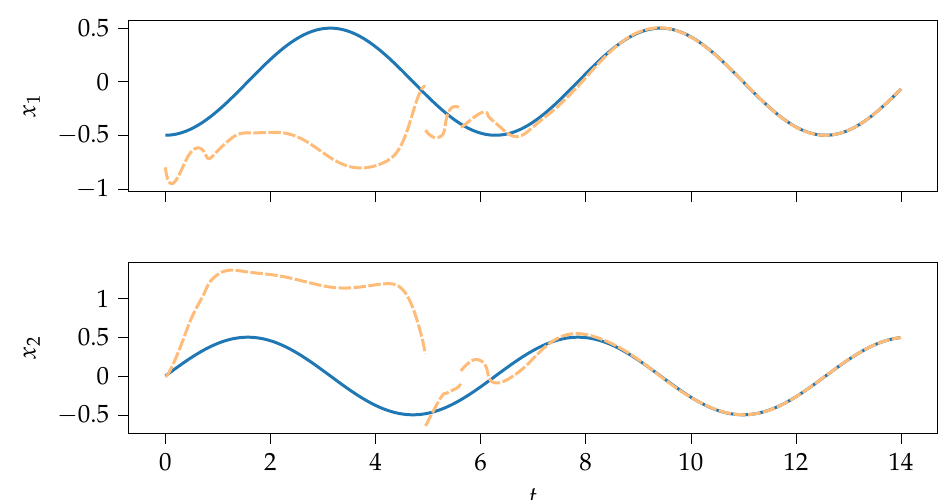
Figure 7. Trajectories for the system state x (blue/dark/solid) and the projected observer state ˆ x (orange/light/dashed) of the system